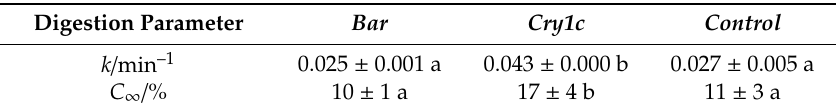
Figure 2. Digestograms of retrograded maize fitted using the nonlinear least-squares fit (NLLS) and LOS treatment [ln(d C / d t ) against t ] based on duplicate measurements. The NLLS treatment is only used over the region in which the LOS plots suggest a single first-order loss. Table 2. Starch digestion rate coe ffi cient and percentage of undigested starch for each phase, obtained by NLLS. Mean ± SD is calculated from duplicate measurements. Di ff erent letters within a row indicate significant di ff erences ( p <